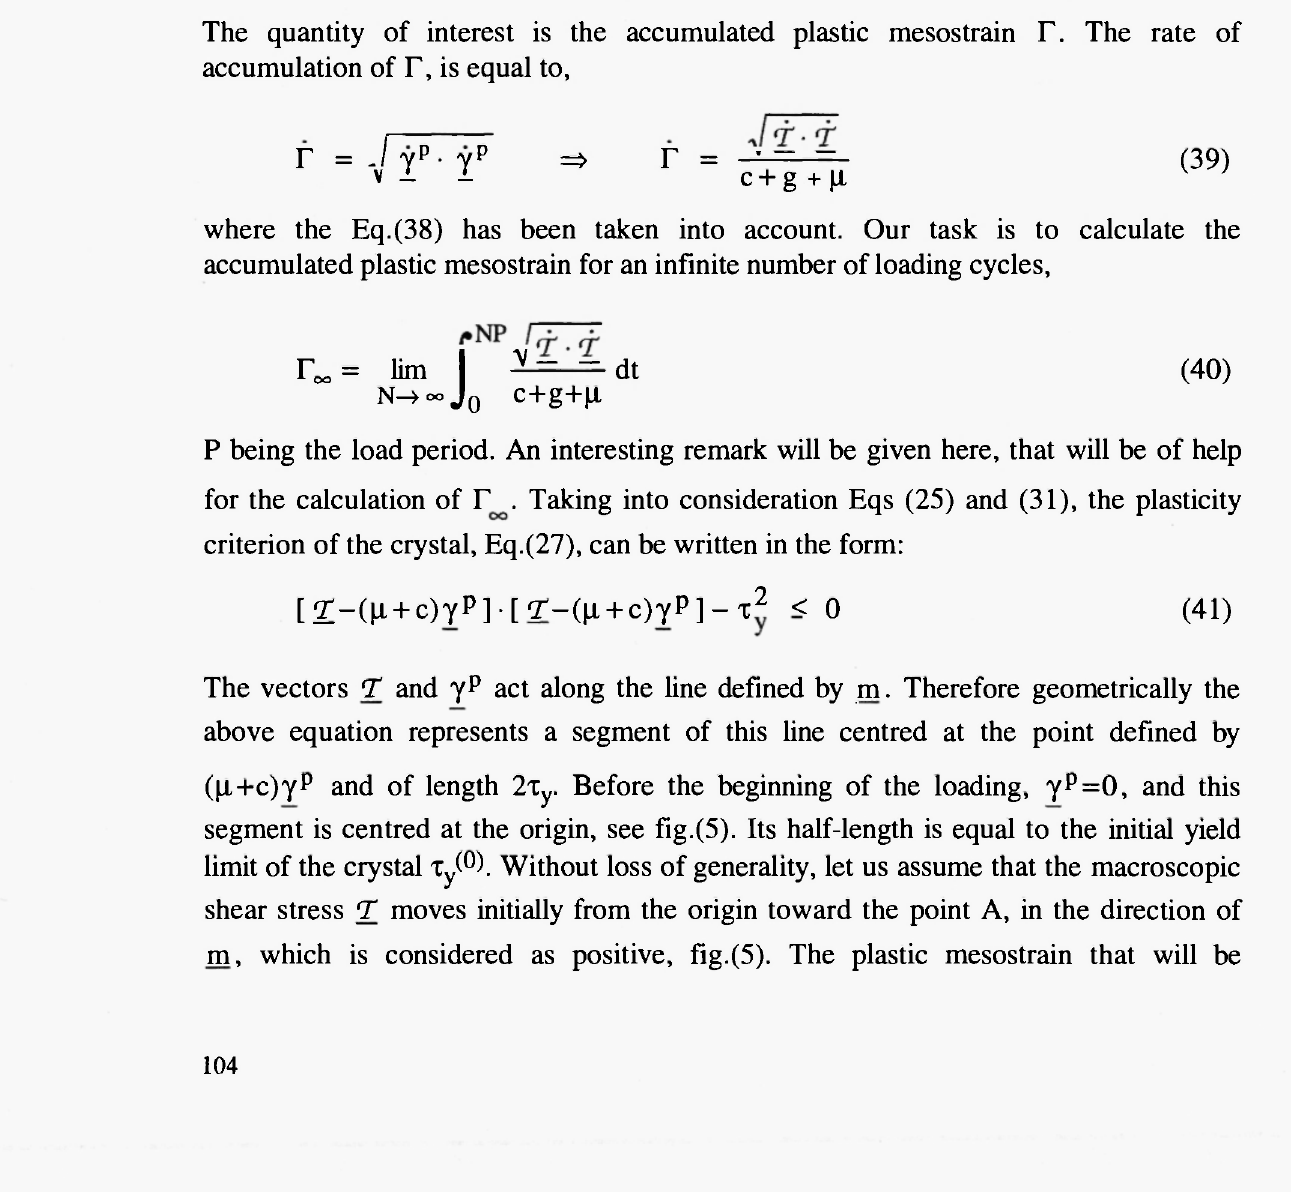
Figure 5. Path Ψ of the shear stress C acting on Δ and corresponding path A-B-A of the resolved shear stress acting on an easy glide direction